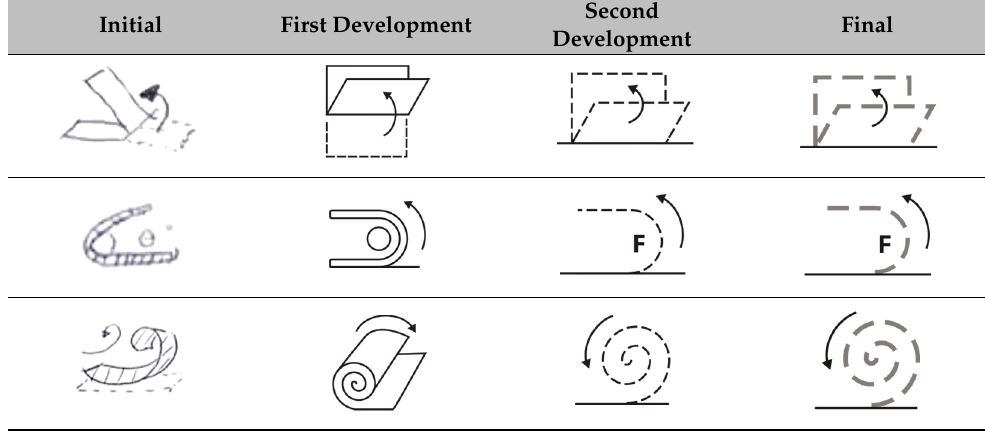
Table 2. The symbol development process for shape-changes behaviours.